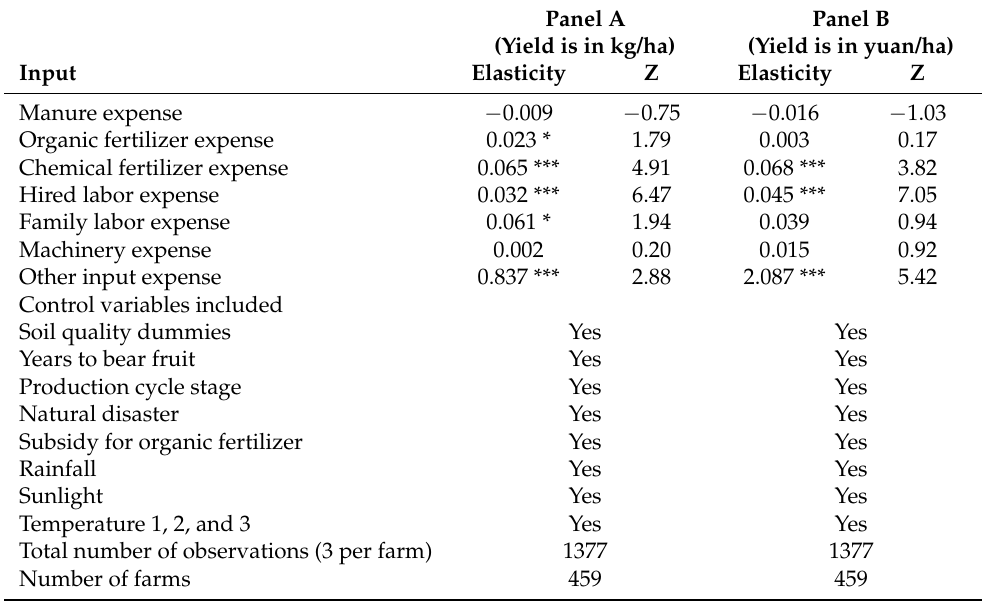
Table 4. Estimated mean values of partial output elasticities with inputs measured in value terms.